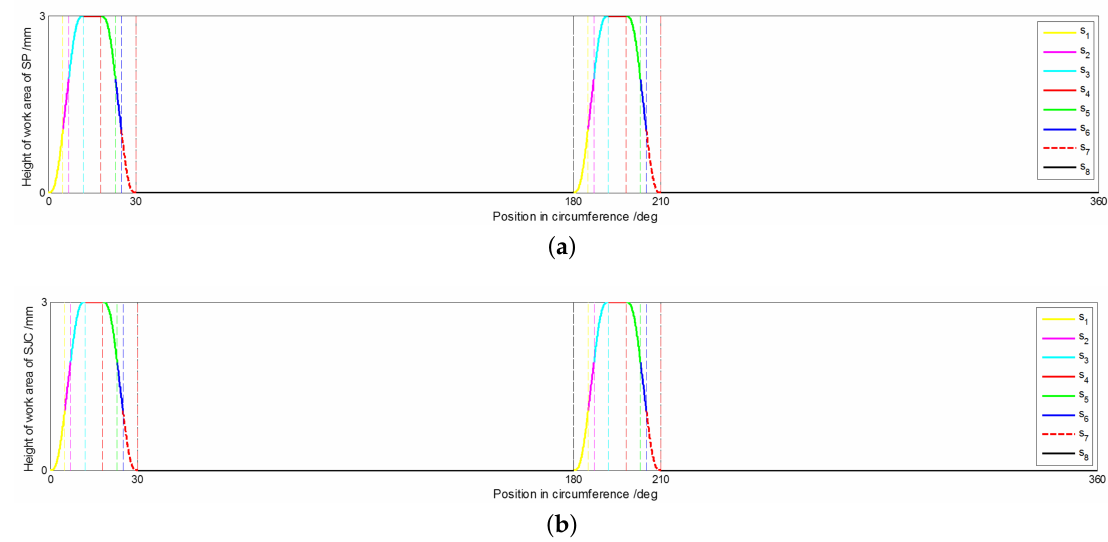
Figure 6. The height curves of SPC and SJC. ( a ) The work height of SPC’s work area. ( b ) The work height of SJC’s work